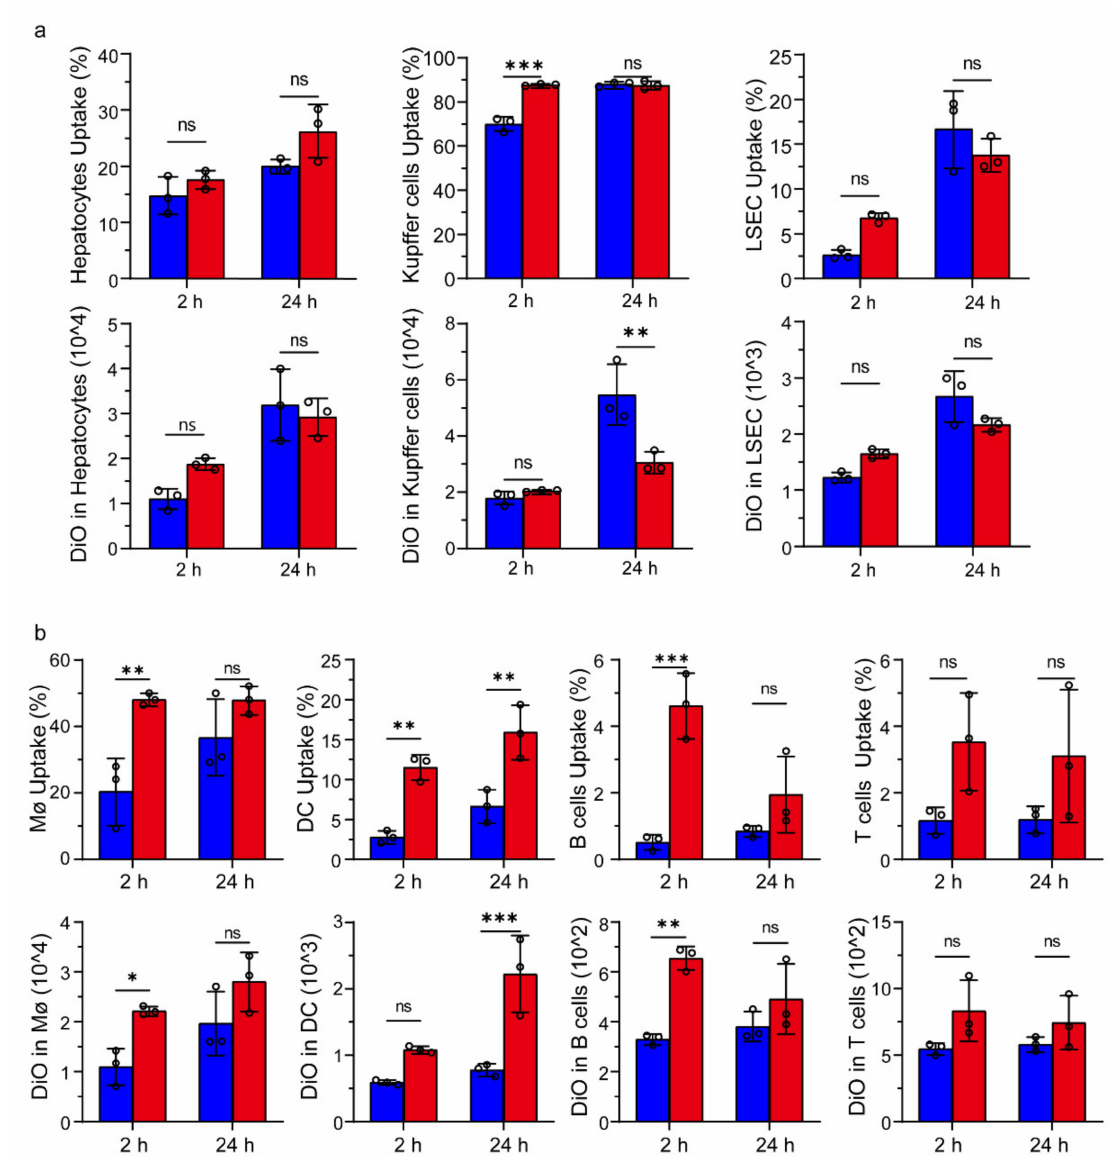
Figure 7. Uptake of CTB-sLip/DiO by hepatic cells and splenic cells. ( a ) Kupffer’s cells and liver sinusoidal endothelial cells (LSECs) were marked with F4/80 and CD146, respectively. ( b ) Splenic macrophages (M Φ ), DC cells, splenic B cells, and T cells were marked with F4/80, CD11c, CD19, and CD3, respectively. Data are means ± SDs ( n = 3). * p < 0.05, ** p < 0.01, *** p < 0.001; ns represents nonsignificant based on grouped two-way